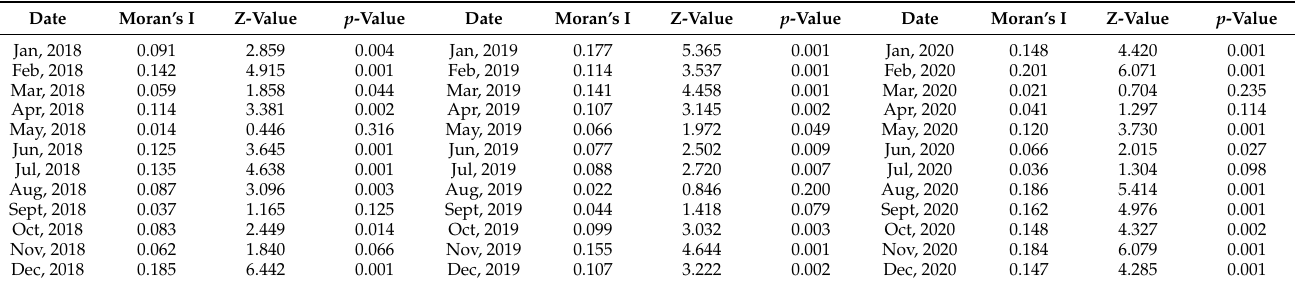
Table 2. The results of the spatial autocorrelation analysis of the residuals from the PCA-GWR model for PM 2.5 concentration estimation, including the corresponding date, Moran’s I, Z value, and p